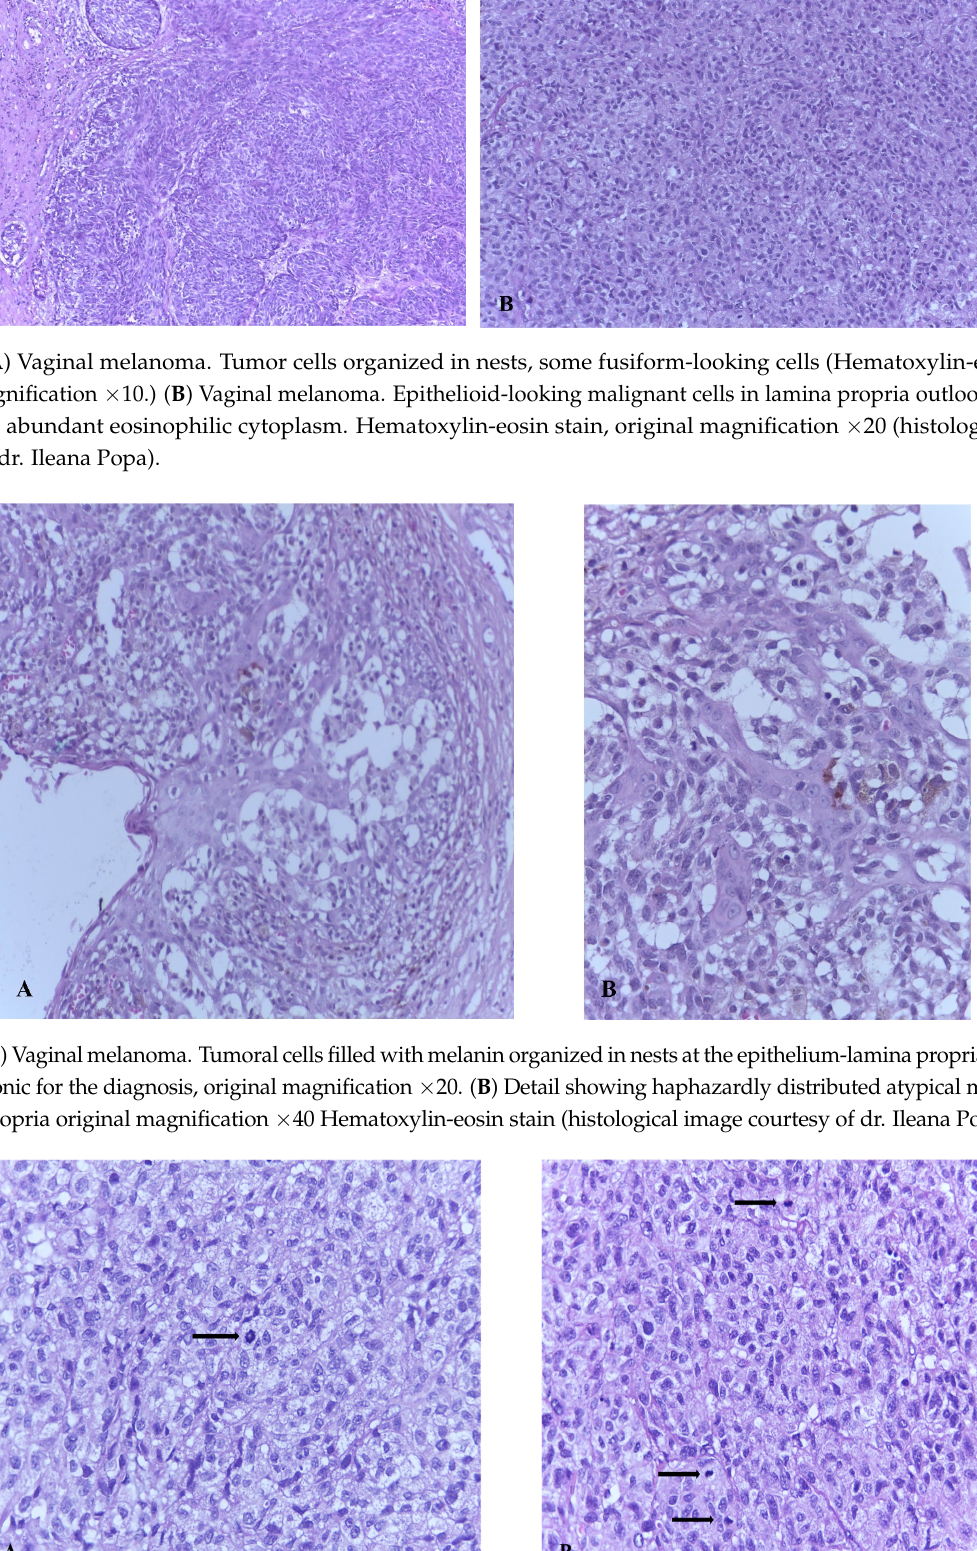
Figure 6. ( A , B ) Vaginal melanoma. Arrows—Nuclear mitoses—original magnification × 40.Hematoxylin-eosin stain (histological image courtesy of dr. Ileana Popa).